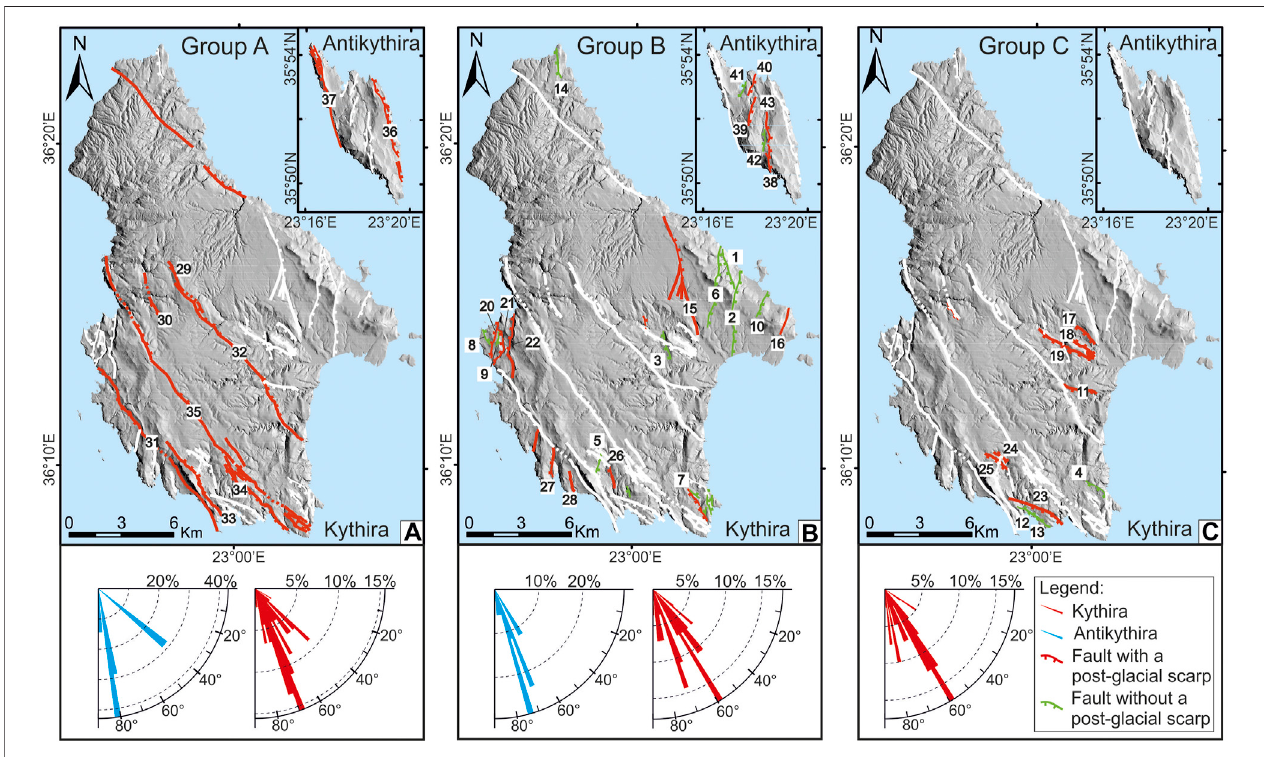
FIGURE4| ShadedreliefmapshighlightingfaultsinKythiraandAntikythirawith(red)andwithout(green)postglacialactivityforGroupA (A) ,GroupB (B) andGroup C (C) . The white faults in each panel represent all other fault types. Fault-dip histograms for Kythira (red) and Antikythira (blue) are shown below each fault group.